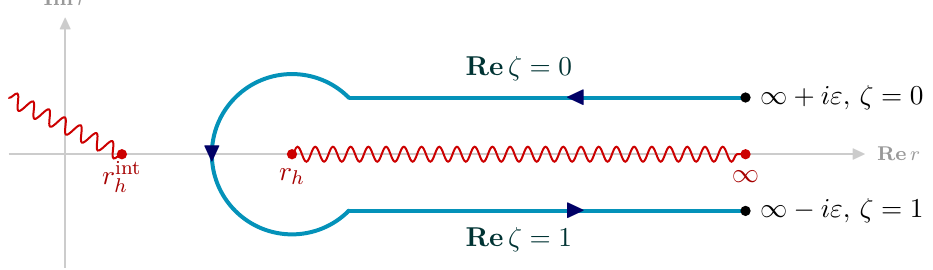
Figure 1 . The radial contour drawn on the complex r plane, at fixed v . The locations of the two boundaries and the two horizons have been